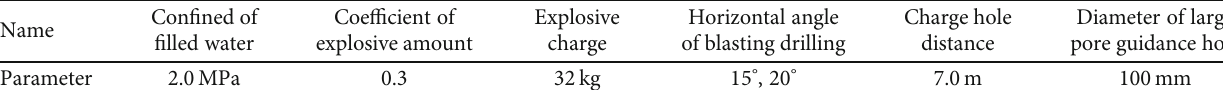
Table 3: The basic parameters of the con fi ned blasting in water- fi lled deep hole presplit technology. Name